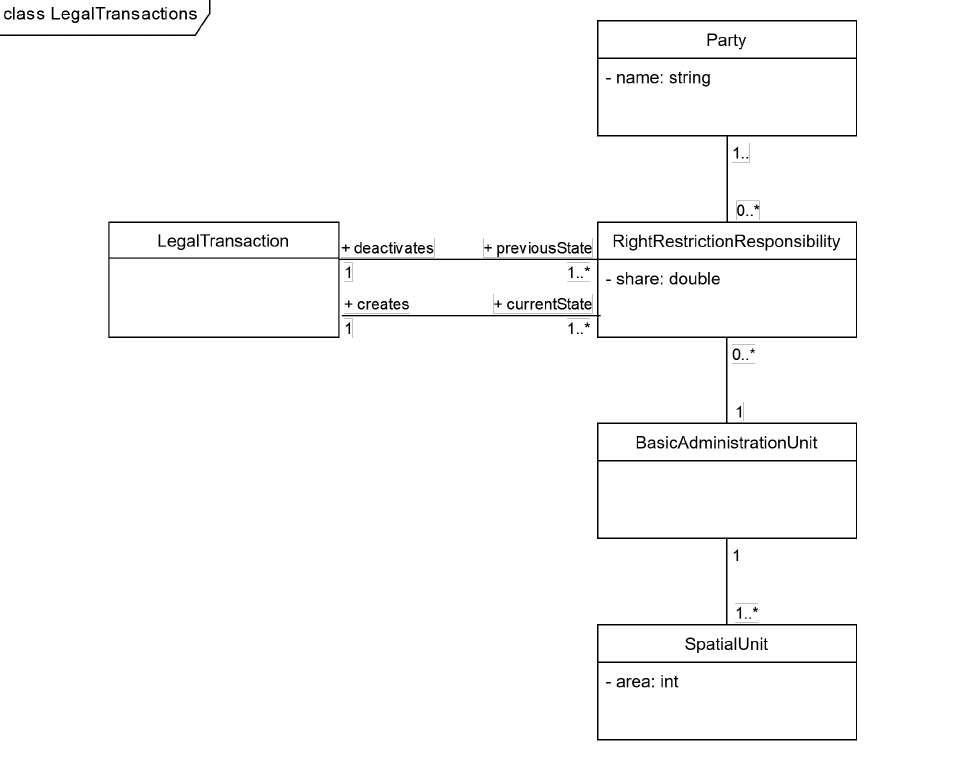
Figure 2. Legal transactions’ key